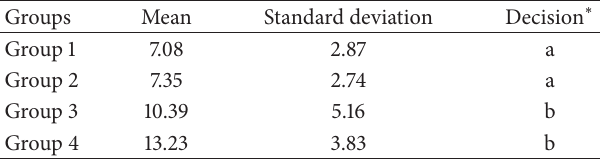
Table 2: Mean values for voids within the cement.